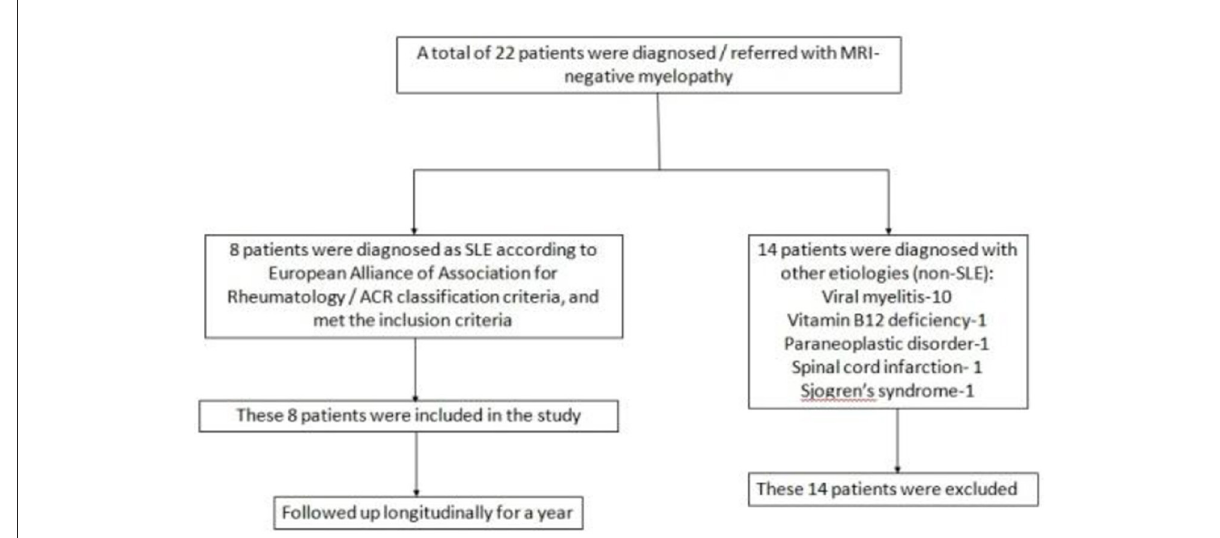
FIGURE1 Flowchart showing the study design and enrolment of study